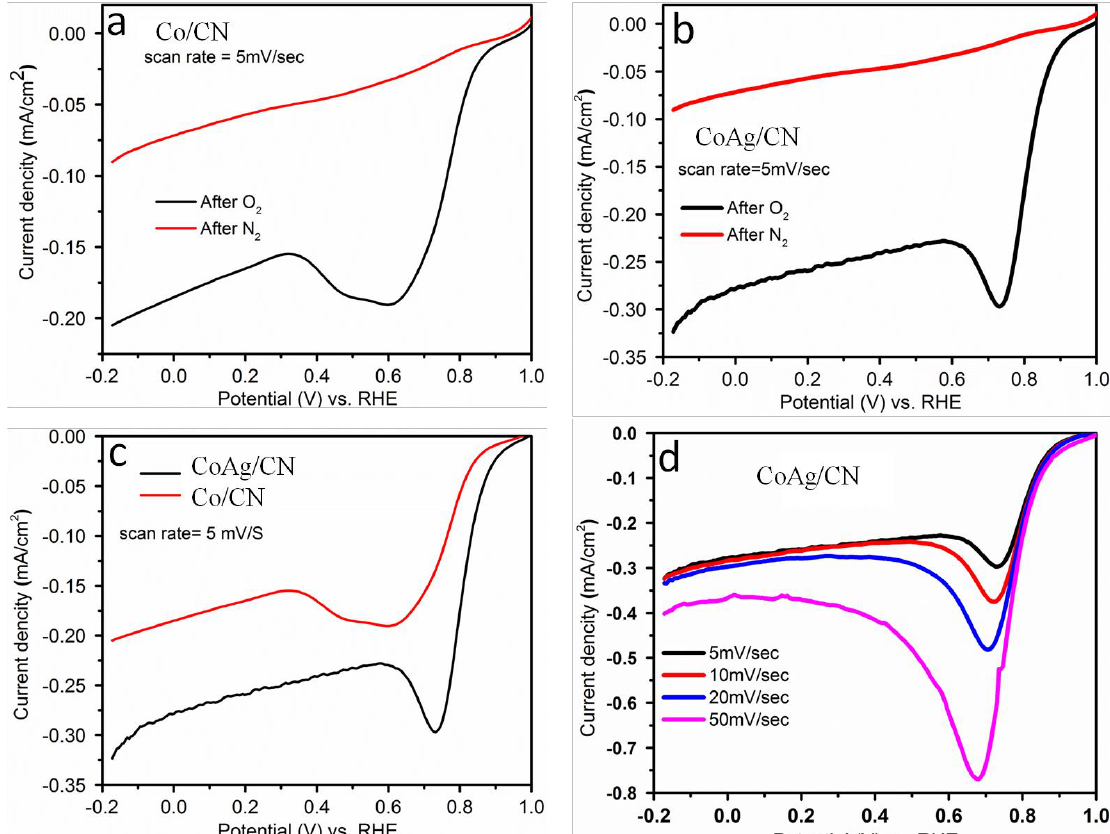
Figure 5. ( a ) Linear sweep voltammogram curve of Co/CN after N 2 and O 2 purge; ( b ) Linear sweep voltammogram curve (LSV) of CoAg/CN after N 2 and O 2 purge; ( c ) LSV comparison of Co/CN and CoAg/CN at a scan rate of 5mV/sec; ( d ) LSV polarization curves of CoAg/CN at different scan rates.